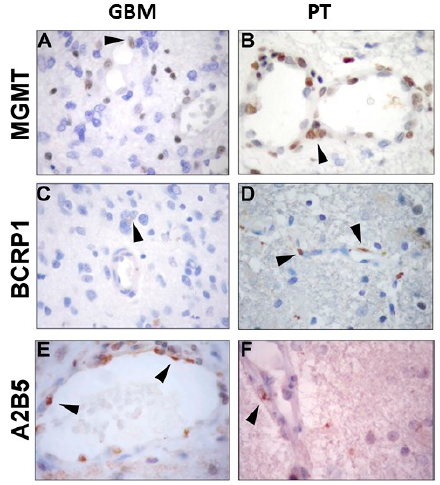
Figure 1. Immunohistochemistry analysis of glioblastoma (GBM) and peritumoral (PT) areas of surgical samples. Primary tumor specimens and adjacent brain tissue were collected, fixed in 10% formalin, and analyzed by means of immunohistochemistry. Arrowheads indicate the immunore- activity of O6-methylguanine methyltransferase (MGMT), breast cancer resistance protein (BCRP1), and A2B5 in both areas. ( A , C , and E ) MGMT, BCRP1, and A2B5 expression in GBM samples; ( B , D , and F ) MGMT, BCRP1, and A2B5 expression in PT tissue.